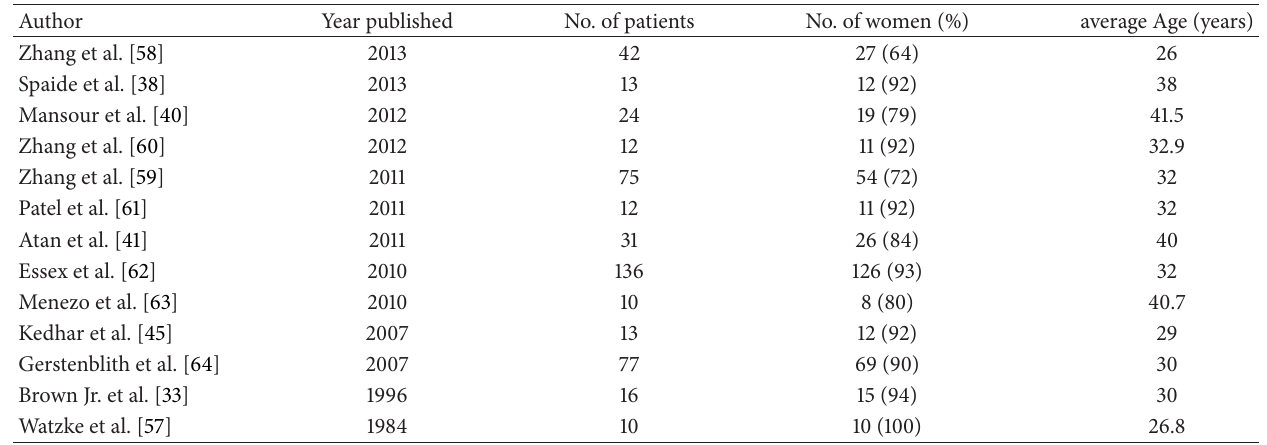
Table 5: Reports for punctate inner choroidopathy.